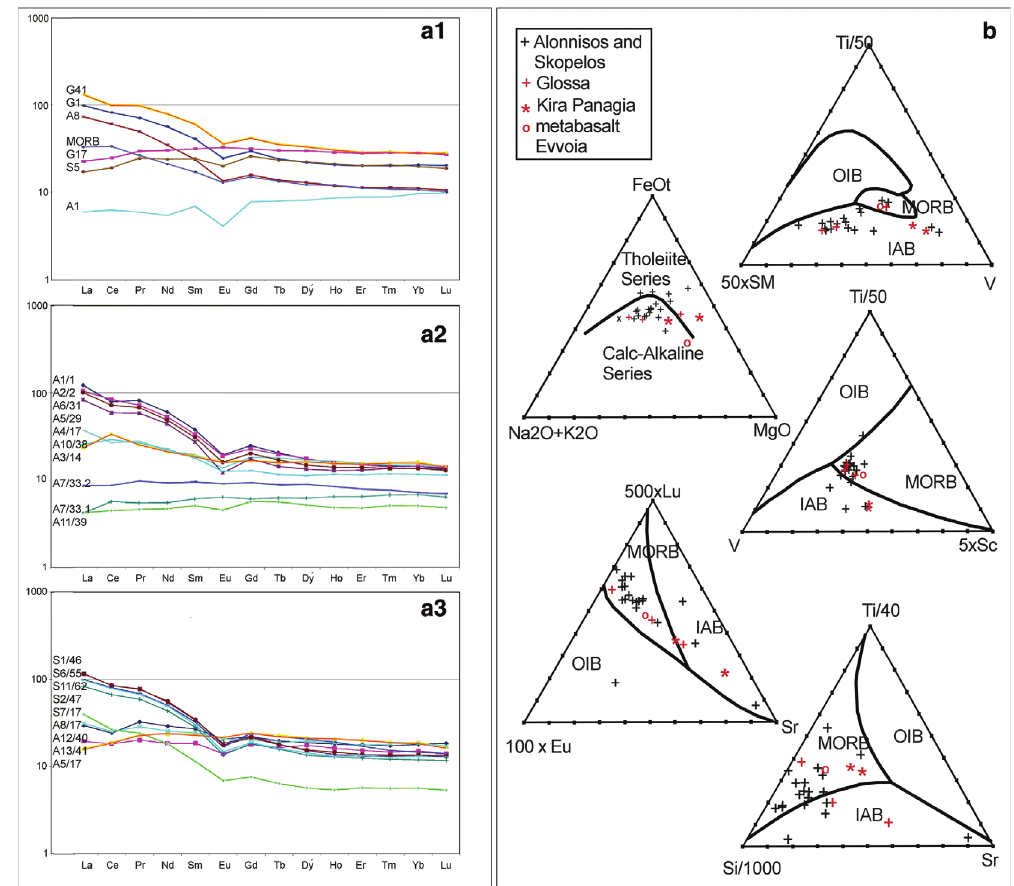
Therefore, in agreement with previous published views [7, 8], the Triassic formations of the Glossa rEE plots against chondrite (ppm) and discrimination diagrams. peninsula are considered to belong to the pre-Upper Triassic basement of skopelos, on the grounds of topographic/stratigraphic superposition of the Triassic dolomites. The petrographic (a1–a3) The rEE plots are of rocks from the shear-zone formation with the and geochemical data correlate well with the Middle Triassic basement of Evvoia, and the exception of a MOrB and peridotite Glossa series bears little resemblance to the Eohellenic complex, which in Evvoia, consists of from Evvoia and three samples from serpentinised peridotite, gabbro, basalt and radiolarian cherts. the Glossa area (G41, G1, G17). The plots indicate that the samples from the shear zone are of basaltic origin, mostly having negative Eu anomalies. There are mainly two groups: those The shear zone with relative light rEE enrichment and those with relative light rEE depletion. Contamination occurred because of tectonic mixing with limestones, for example, s7/17, a calc-schist. (The plots, a1–a3, of the individual samples are coincidentally arranged in the order that they came from the laboratory, the sample codes are on the left. Their order does not correspond to the geochemistry Table 2a and 2B.) (b) Discrimination diagrams compiled from samples of Table 2a and 2B. The aFM diagram shows that the samples correspond to the calc- alkaline series with few exceptions. The discrimination diagrams indicate MOrB provenience and IaB affinities (see